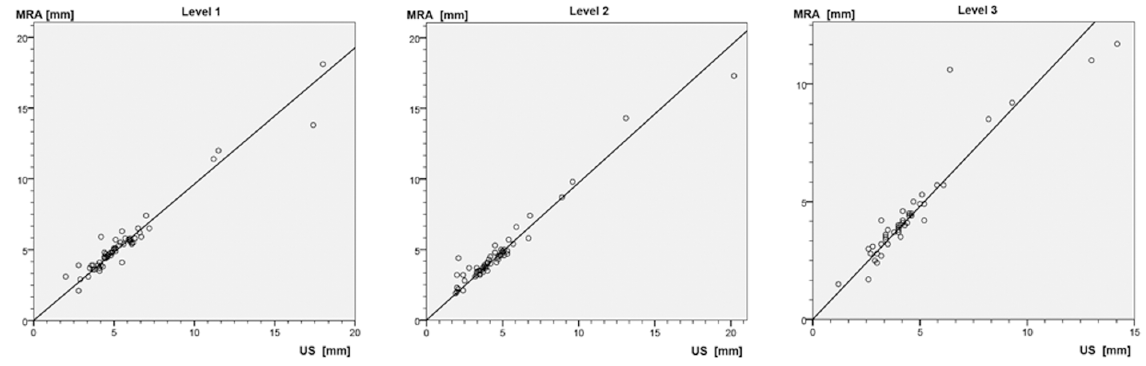
Figure 7. Correlation between MR-angiographic (MRA) and duplex sonographic (DUS) values in the three levels. Pearson correlation coefficients R 2 : level 1: 0.989; level 2: 0.986, level 3: 0.973.